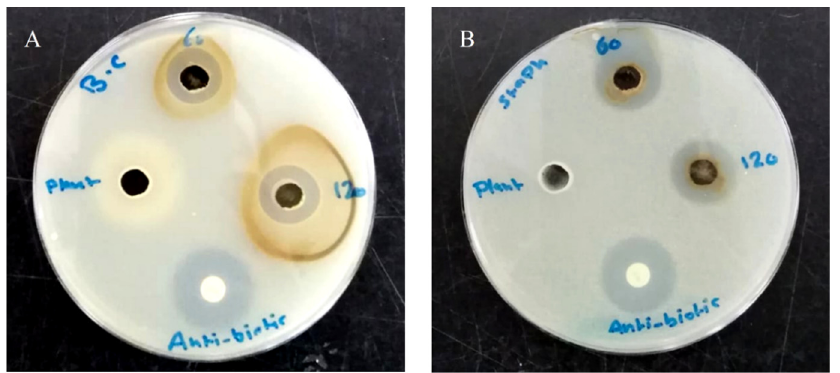
Figure 4. Photograph showing the antimicrobial activity of AgNPs against B. cereus ( A ) and S. aureus ( B